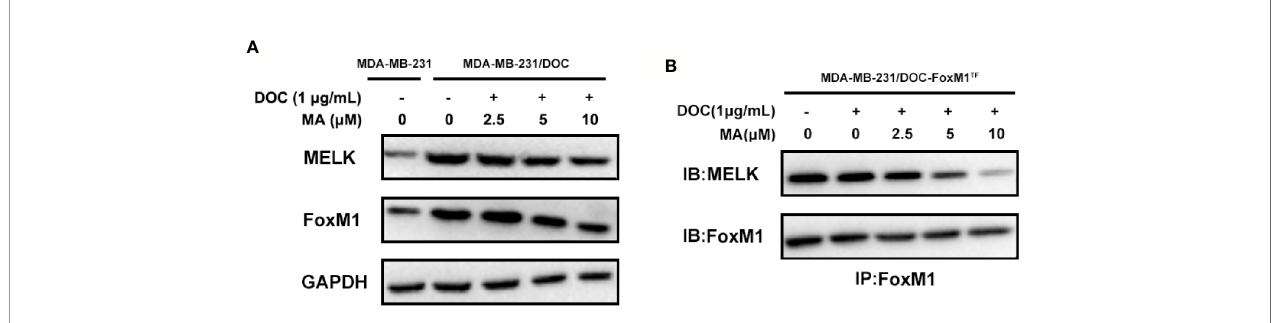
FIGURE 3 | The combined effect of docetaxel (DOC) and maslinic acid (MA) on the expressions and interaction of maternal embryonic leucine-zipper kinase (MELK) and FoxM1 in MDA-MB-231/DOC cells. (A) MDA-MB-231 and MDA-MB-231/DOC cells were incubated with or without the indicated drugs for 24 h, and western blot analysis was used to evaluate the expression levels of MELK and FoxM1. (B) MDA-MB-231/DOC-FoxM1 TF cells were incubated with or without the indicated drugs for 24 h, and co-immunoprecipitation analysis was used to evaluate the interaction of MELK and FoxM1. Every fi gure was representative of three independent